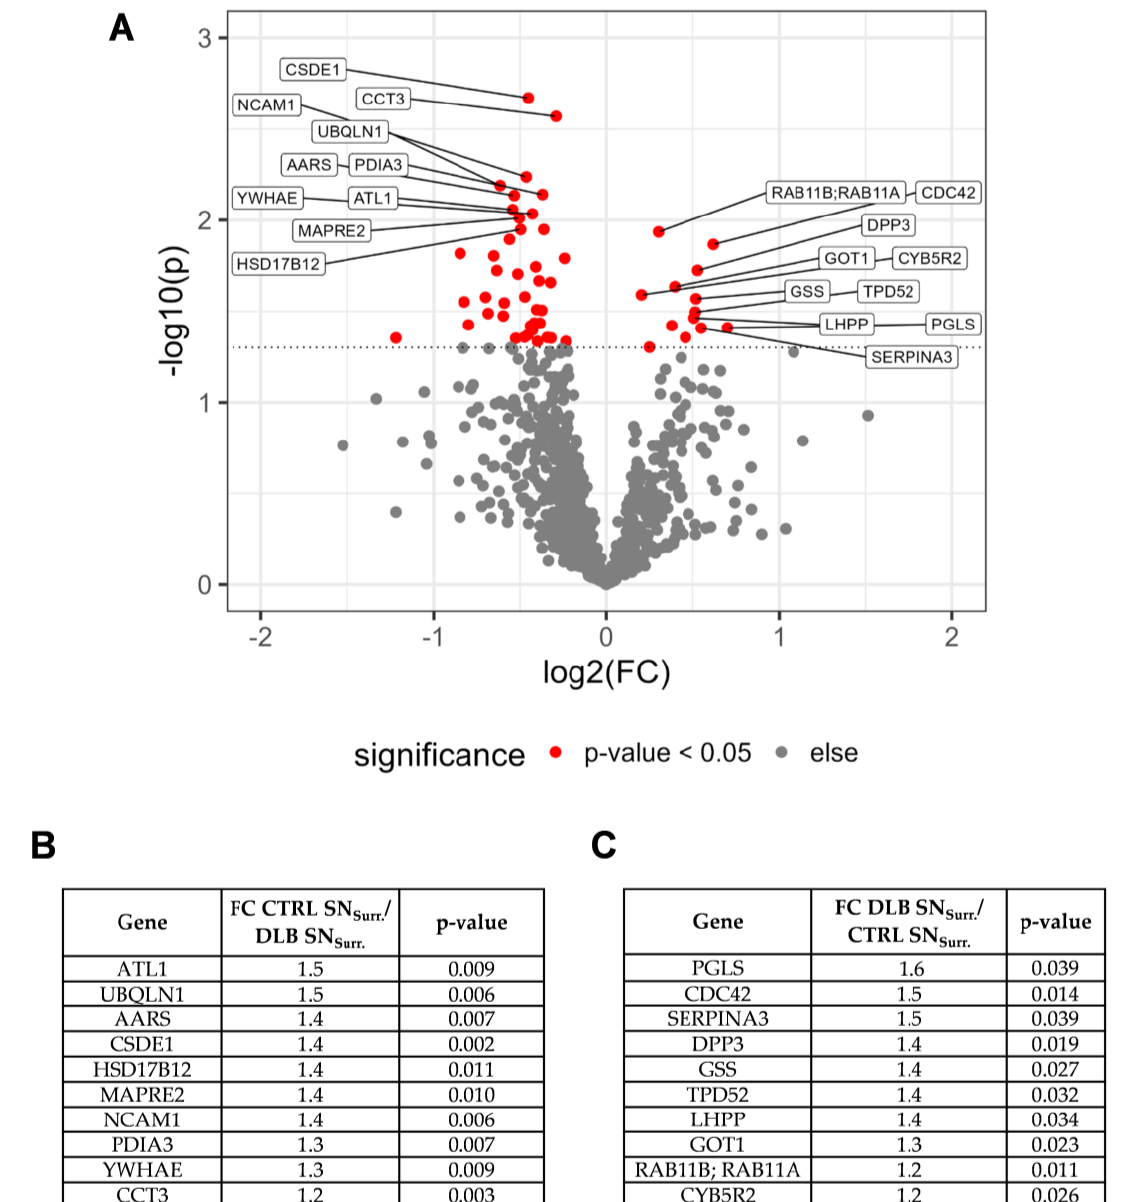
Figure 3. Results of the quantitative comparison of proteins in SN Surr. tissue of CTRL and DLB cases. ( A ): Volcano plot displaying − log 10 -transformed p -values and log 2 -transformed fold changes (FC) of proteins matching the criteria for the quantitative comparison. Proteins with highest Euclidean distances on both sides are indicated with their respective gene symbols. ( B ): Summary of fold change and p -value for proteins with highest Euclidean distances and higher abundances in SN Surr. tissue of CTRL cases. ( C ): Summary of fold change and p -value for proteins with highest Euclidean distances and higher abundances in SN Surr. tissue of DLB cases. ATL1: atlastin-1; UBQLN1: ubiquilin-1; AARS: alanine-tRNA ligase, cytoplasmic; CSDE1: cold shock domain-containing protein E1; HSD17B12: very-long-chain 3-oxoacyl-CoA reductase; MAPRE2: microtubule-associated protein RP/EB